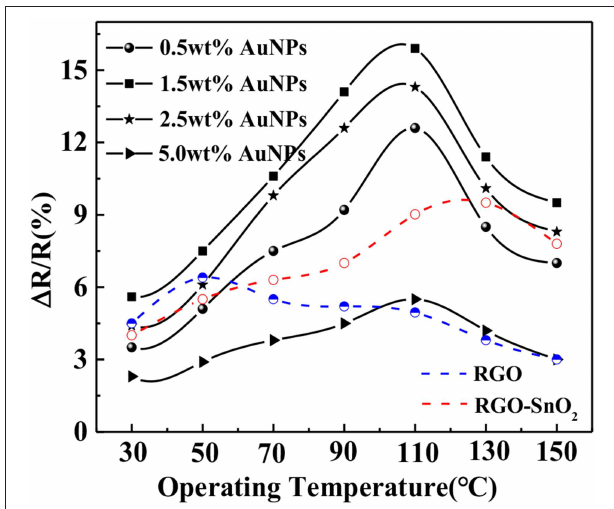
FIGURE 7 | The response of the sensors to 50 ppm SOF 2 at the temperature of 30–150 ◦